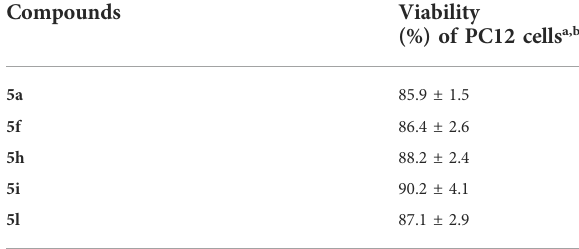
TABLE 3 Effects of compounds 5a, 5f, 5h, 5i, and 5l on cell viability in PC12